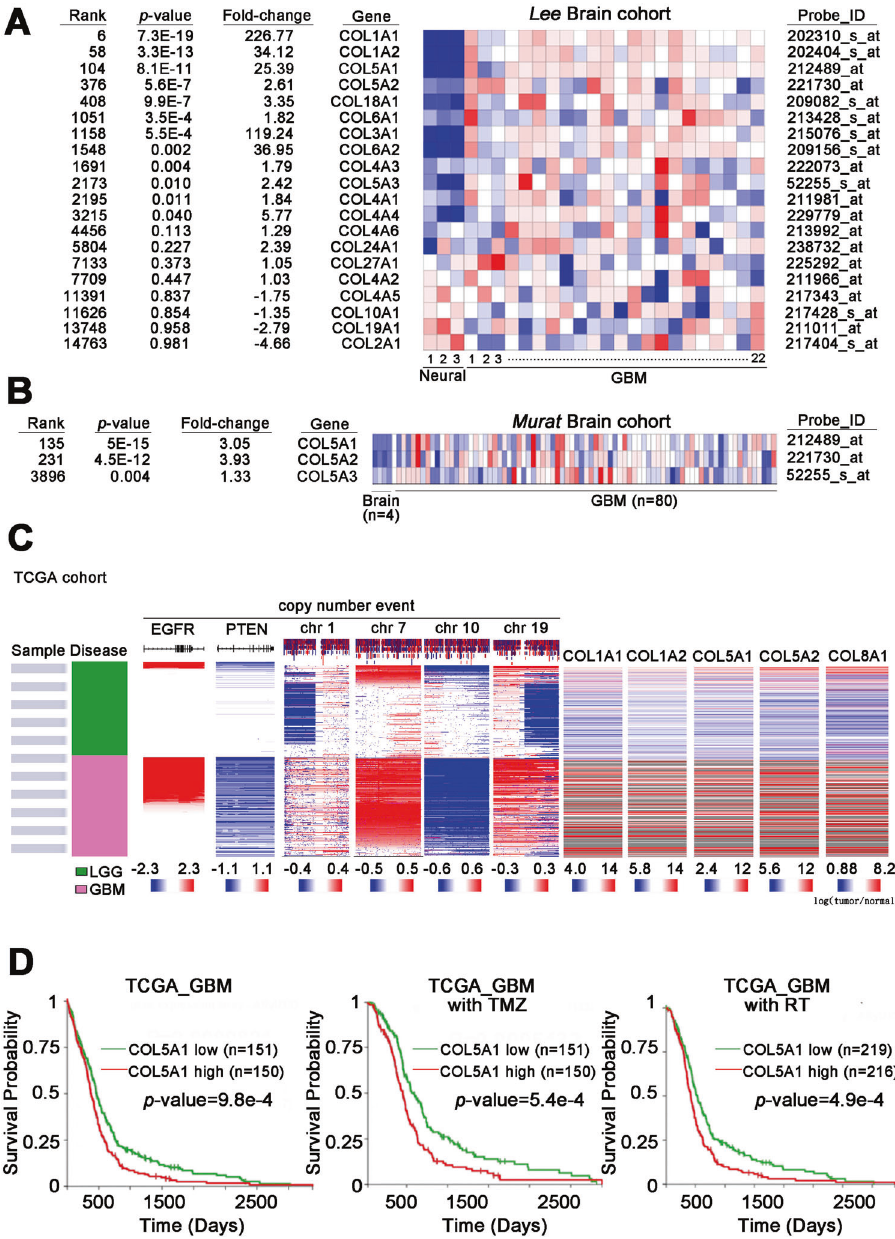
Fig. 1 COL5A1 mRNA expression in various subtypes of glioma and its correlations with several events. A The heatmap shows the correlation between the mRNA expression levels of various collagen family members in neural/GBM tissues from Oncomine (Lee brain cohort, n = 25). B The heatmap shows the correlation between the mRNA expression level of collagen V family members in normal brain/GBM tissues from Oncomine (Murata brain cohort, n = 84). C The heatmap shows the endogenous mRNA expression levels of several targets, genetic alteration events, and subtypes in the TCGA-speci fi c template (copy number for EGFR, PTEN, and chromosomes 1, 7, 10, and 19 in TCGA brain tumors, n = 1119). D Kaplan – Meier curves of overall survival in glioblastoma patients with or without TMZ treatment and radiotherapy based on a high or low COL5A1 mRNA expression level ( p = 9.8e − 4, p = 5.4e − 4 and p = 4.9e − 4, respectively). The signi fi cance of the differences in ( D ) was analyzed using Student ’ s t